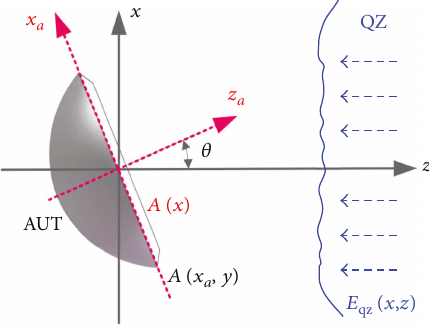
Figure 11: The far- fi eld pattern measurement in the